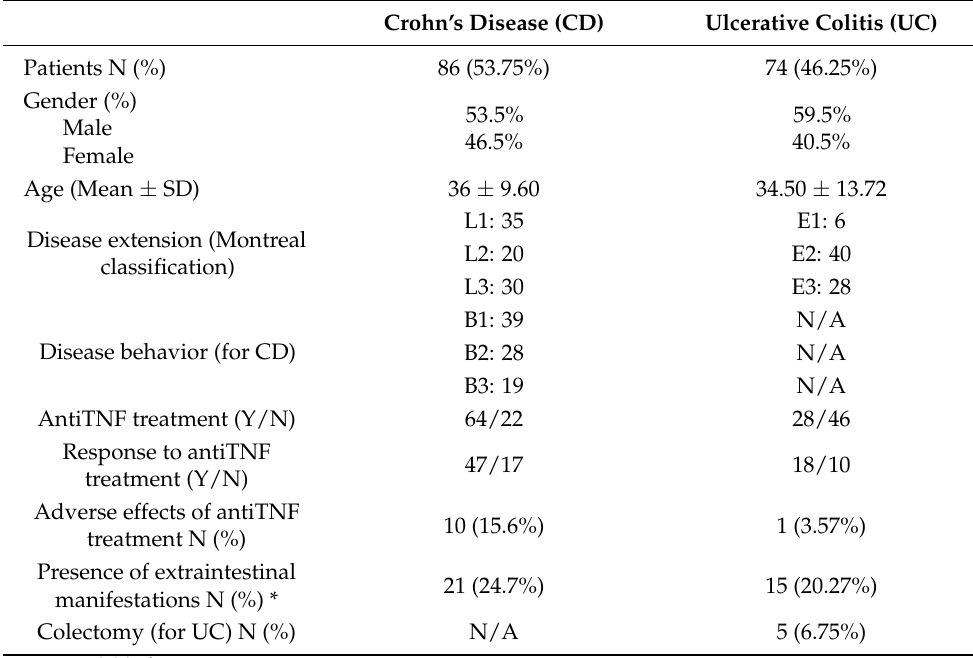
Table 2. Demographic and phenotypic characteristics of enrolled